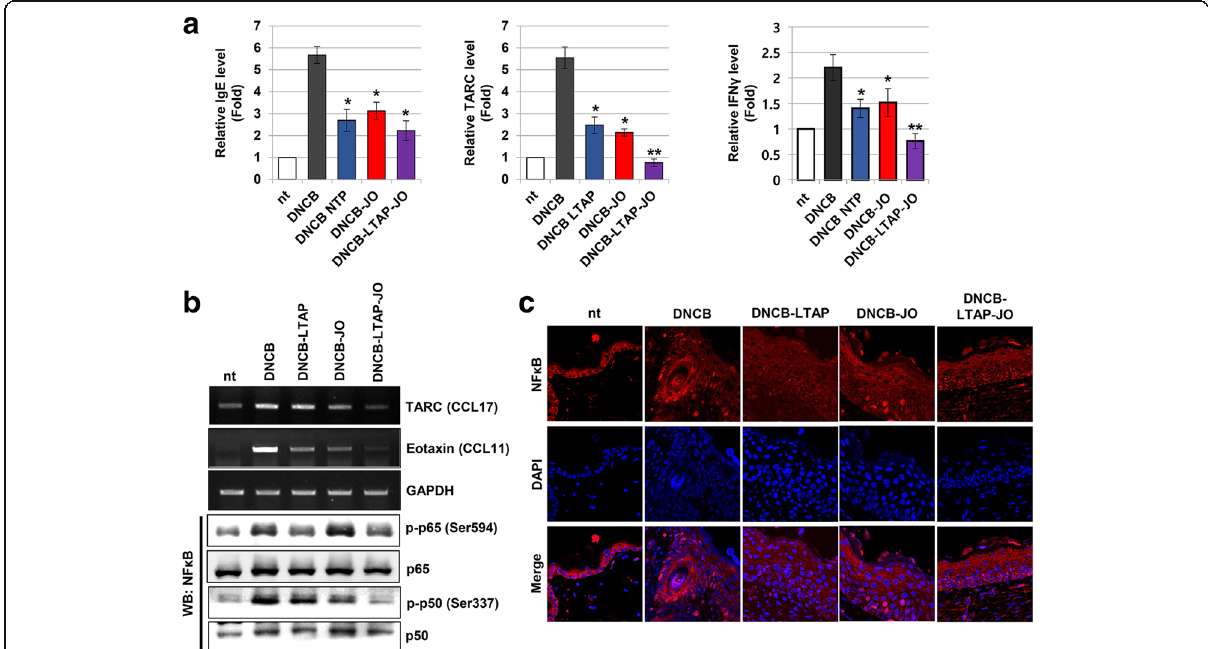
Fig. 5 The effect of LTAP-JO on DNCB-mediated molecular and biological changes in the skin lesion. ( a ) The levels of IgE, TARC, and IFN γ in the dorsal skin tissues of mice were measured using an ELISA kit. Data are shown as the relative level of the proteins, and represents the mean ± SEM ( n = 5). Means with the symbols (*, **) indicate significant differences ( p < 0.05). ( b ) The result of the RT-PCR and Western Blot assay using the skin tissues. Data shown are representatives of 4 independent experiments. ( c ) The location of NF κ B in the skin tissue was monitored by an immunofluorescence assay against NF κ B. Photographs were taken under a confocal microscope at 400× magnification. Data shown are the representatives of each group of